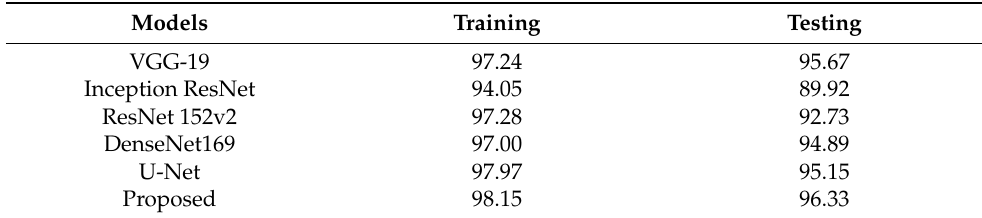
Table 4. Comparison of the testing and training accuracy of the proposed model with traditional models.